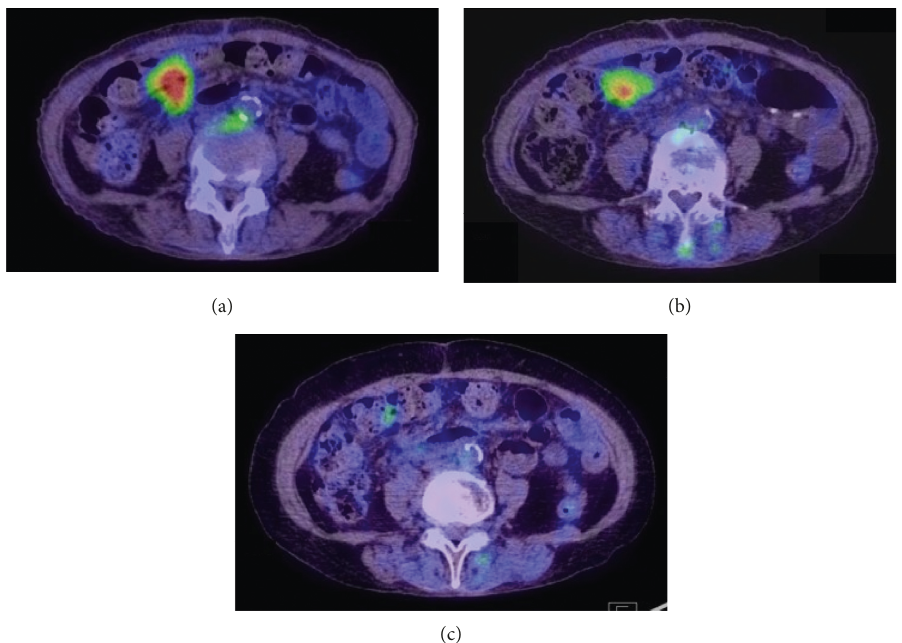
Figure 5: Time course of PET-CT findings regarding the duodenal mass in response to treatment, PET-CTshows (a) high FDG uptake (SUV max � 9.2) at the duodenum prior to immunochemotherapy, (b) reduced uptake (SUV max � 5.1) after radiation, and (c) barely detectable uptake (SUV max < 1.0) after finishing